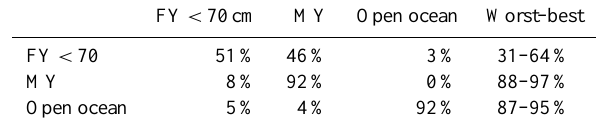
Table 1. Classification matrix of CS-2-based classification (rows) and AARI ice chart (columns), November 2013. Last column shows the best and the worst hit rates of the three 5-day periods. FY < 70cm MY Open ocean Worst–best 31–64% 88–97% Open ocean